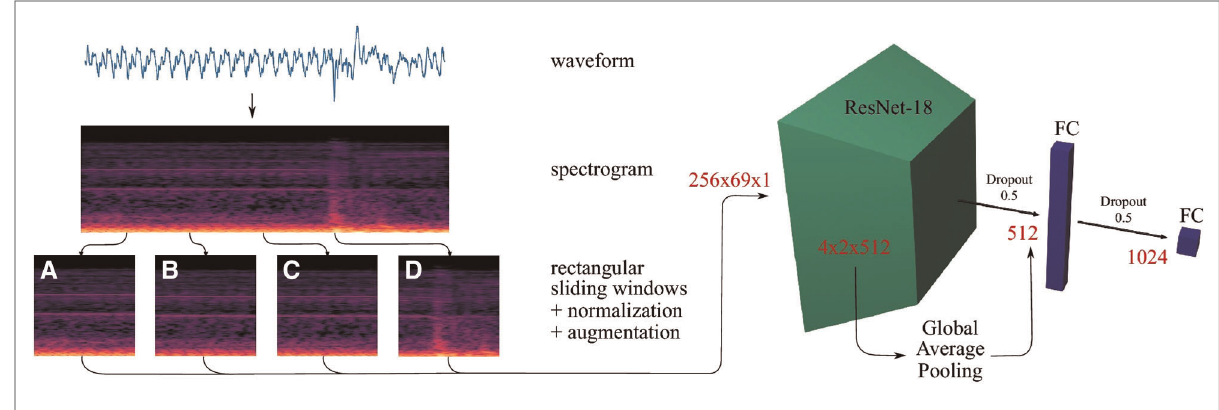
FIGURE 4 Data processing pipeline of a breakthrough detection method